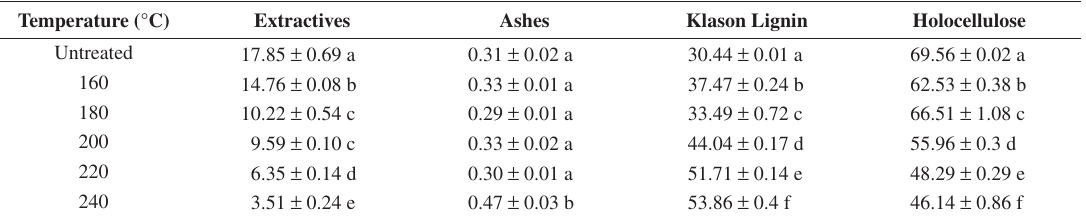
Table 1. Chemical characterization of the thermally treated